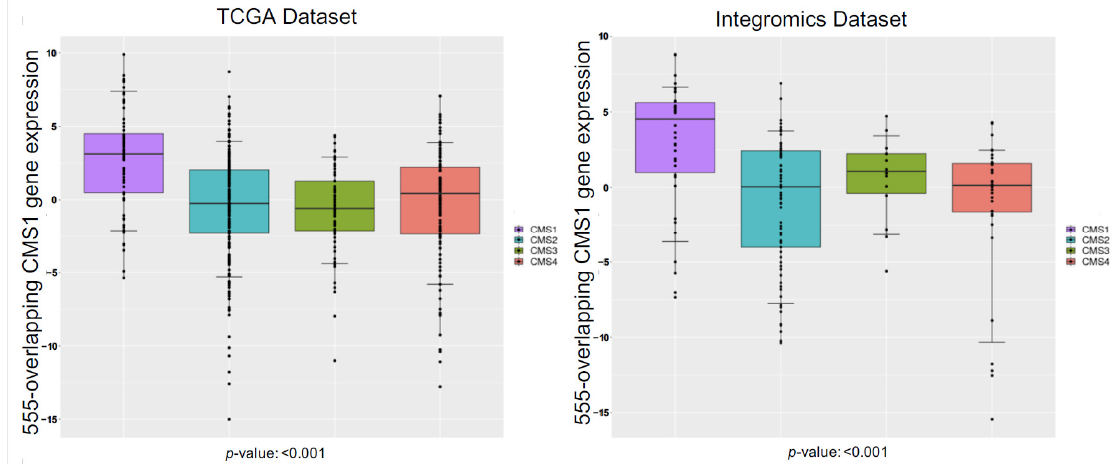
Figure 5. Box-plot distribution analysis of the 555-overlapping CMS1 gene signature, common to TCGA and Integromics datasets. This gene signature was compared across the four consensus molecular subtypes (CMS1, CMS2, CMS3, and CMS4). The y-axis measures the z score relative to the gene expression, horizontal lines define minimum and maximum values, and dots define outliers. The 555- overlapping genes are significantly distributed in CMS1 for both the TCGA and Integromics datasets. One-way ANOVA analysis was used for the statistics to generate p-values and any potential outliers.